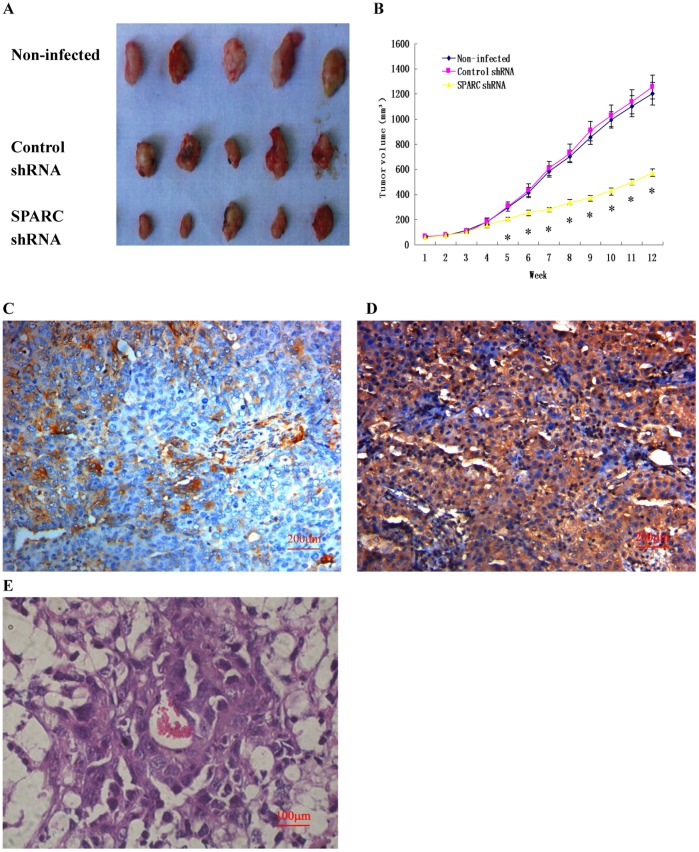
Effect of SPARC knockdown on tumor growth and lung metastasis in nude mice and the downstream target genes of SPARC in ovarian tumor.(A) Photograph of xenografts dissected from nude mice after 3 months subcutaneous inoculation (n = 5). (B) Knockdown of SPARC inhibited tumor growth in vivo. (C) SPARC expression in the tumor formed by SPARC shRNA infected cells as measured by IHC staining (Magnification ×200). (D) SPARC expression in the tumor formed by control shRNA infected cells as measured by IHC staining (Magnification ×200). (E) Photograph of lung metastasis under a microscope after 3 months inoculation through tail vein (n = 10). *P<0.05 versus control.